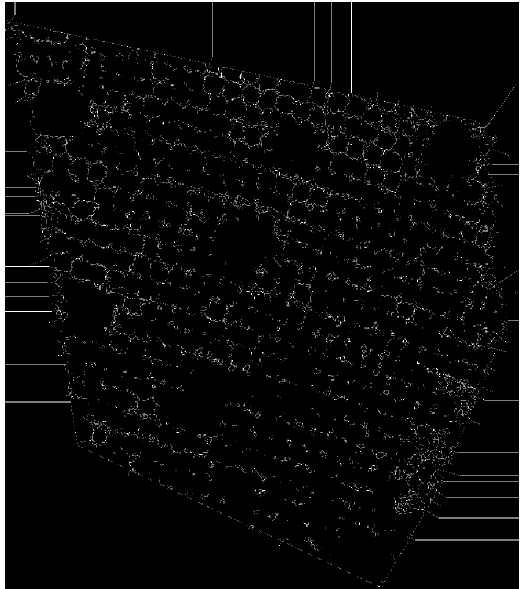
Figure 10. Background markers.